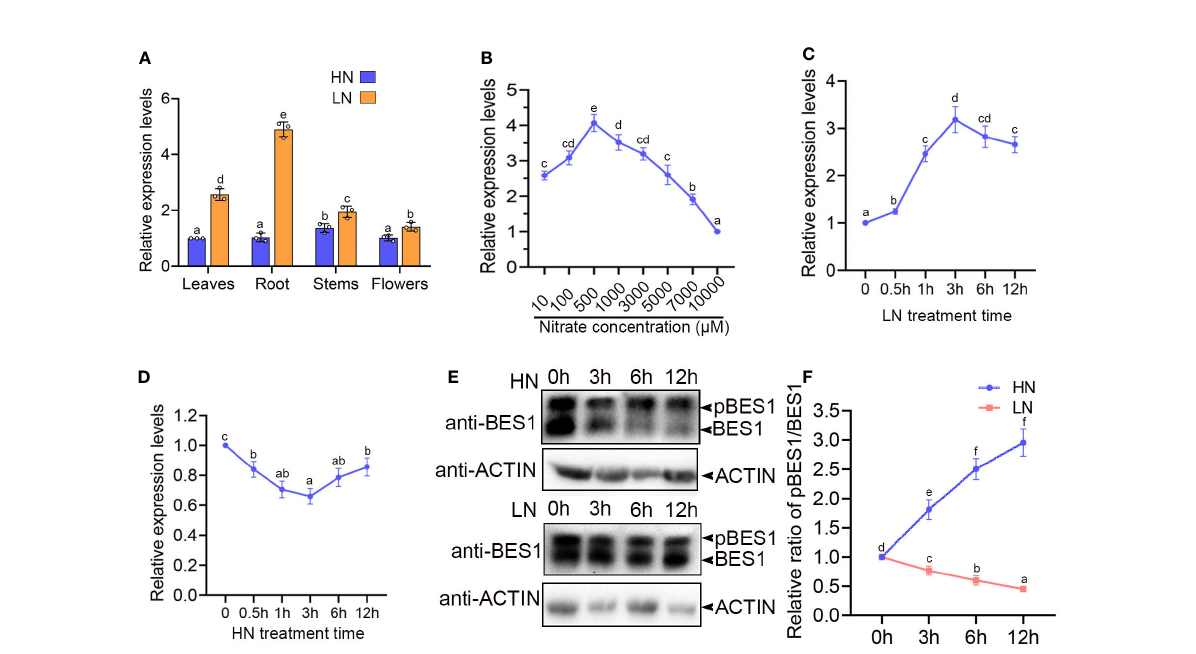
FIGURE 1 LN induces transcript level and dephosphorylation of BES1. (A) The relative expression of BES1 transcripts in the indicated tissues of wide-type plants (Col-0). 5-d-old Col-0 seedlings that grown on 1/2MS medium were transferred to medium with 0.5mM KNO 3 (LN) or 10mM KNO 3 (HN) for 5 weeks and then the different tissues (leaves, root, shoot and fl ower) were collected for gene expression analyses. The relative gene expression levels were presented as values relative to that of leaf sample. (B) Regulation of BES1 expression paten by nitrogen supply. Col-0 seedlings were grown on medium with various NO 3 − concentrations (10, 100, 500, 1,000, 3,000, 5000, 7000 and 10000 m M) for 7 days and the BES1 transcript levels in root tissues were analyzed by qRT-PCR. The relative gene expression levels were presented as values relative to that of the sample from 10000 m M NO 3 − . (C, D) Time courses of BES1 expression in response to N availability. 7day-old Col-0 Seedlings grown on medium were treated by LN (C) or HN (D) for indicated times. The transcript levels of BES1 were assessed in the roots by qRT-PCR. (E) Immunoblots showing the abundance of BES1 proteins in the root tissues of 1-week-old seedlings treated at HN (top panel) or LN (bottom panel) for the indicated time periods. BES1 was detected by western blot using anti-BES1 antibody. ACTIN2 was used as a loading control. pBES1 represents phosphorylated BES1. At least three times were repeated. (F) Quantitative results for Immunoblots results in (E) . The initial ratio of pBES1/BES1 of each treatment were set as ‘ 1 ’ . In all gene expression analyses, ACTIN2 was used as an internal standard. Data are presented as the mean ± SD (n = 3). In all results, different lowercase letters represent statistically signi fi cant differences (p < 0.05, two-way